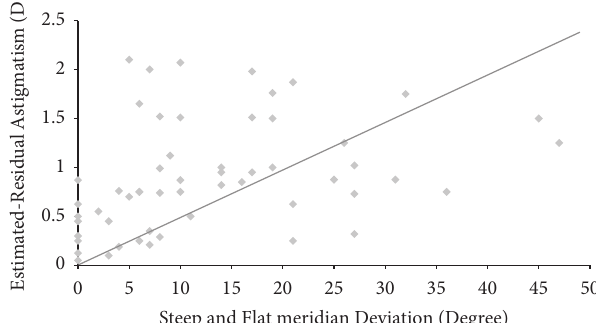
Figure 5: Pearson’s correlation between steep and flat meridian deviation and estimated residual astigmatism. There was a positive correlation between steep and flat meridian deviation and the estimated residual astigmatism D at 6 months ( r � 0.45, P < 0 . 30 ° groups (0.22 ± 0.11) in steep and flat meridian deviations at 6 months ( P < 0 . 05) (Table 4).